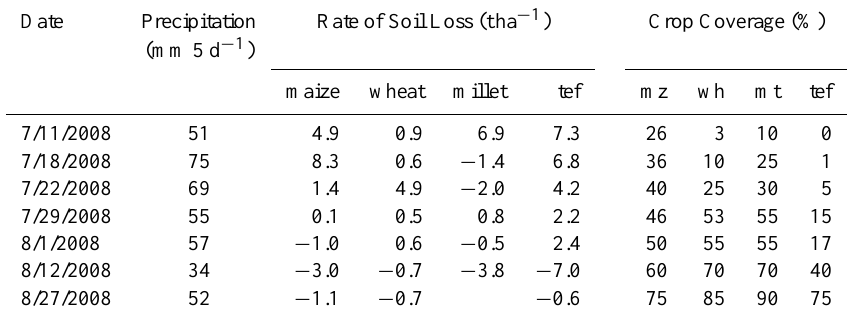
Table 3. Soil loss, percent plant cover on days of observation, and the 5 day antecedent precipitation for upland erosion measurements, mz=maize wh=wheat